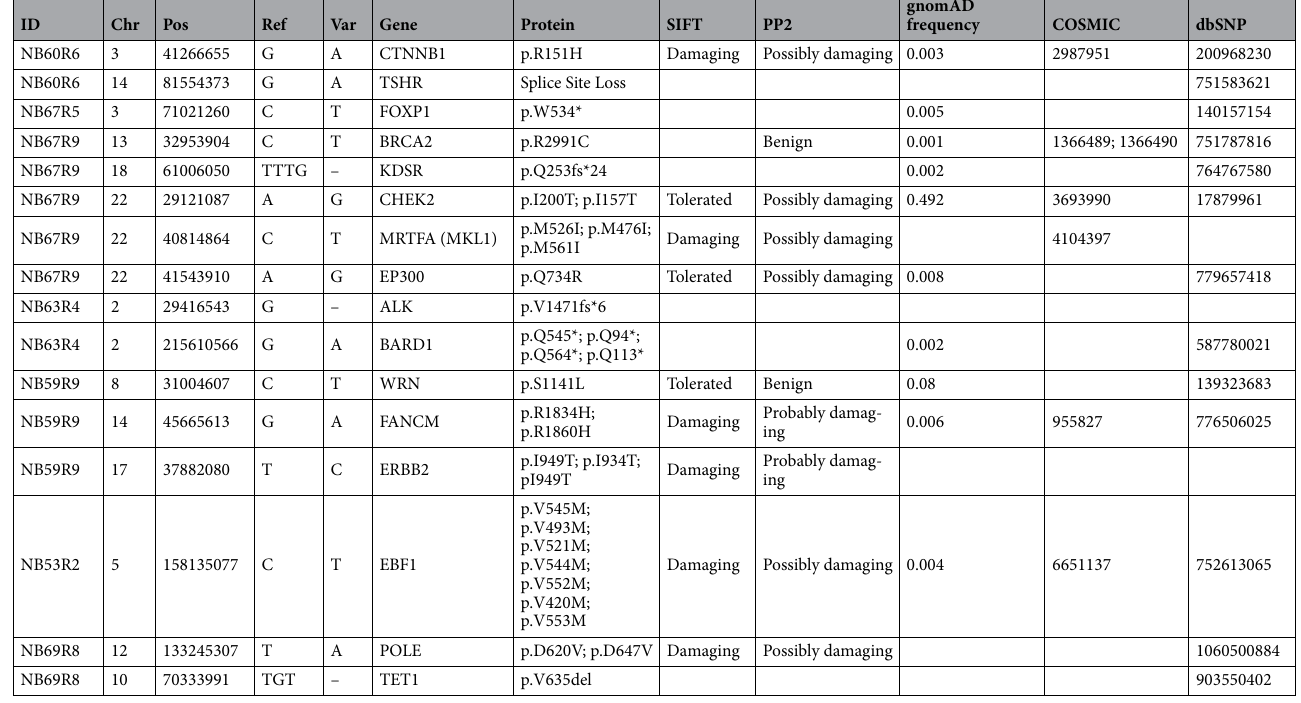
Table 2. Possibly damaging/pathogenic germline